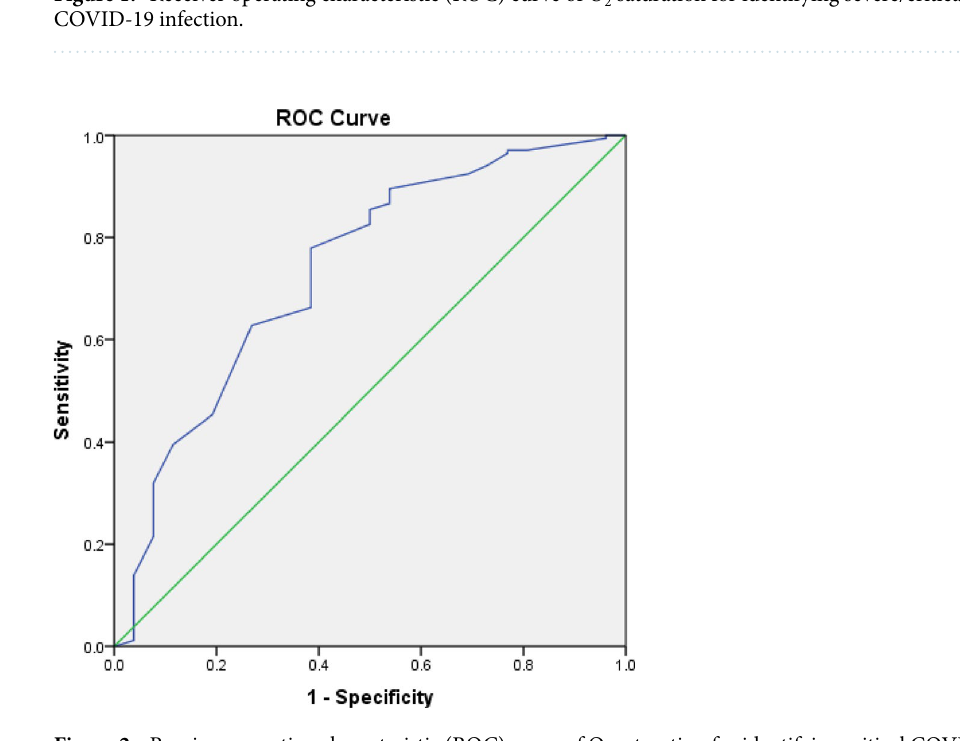
Figure 2. Receiver operating characteristic (ROC) curve of O 2 saturation for identifying critical COVID-19